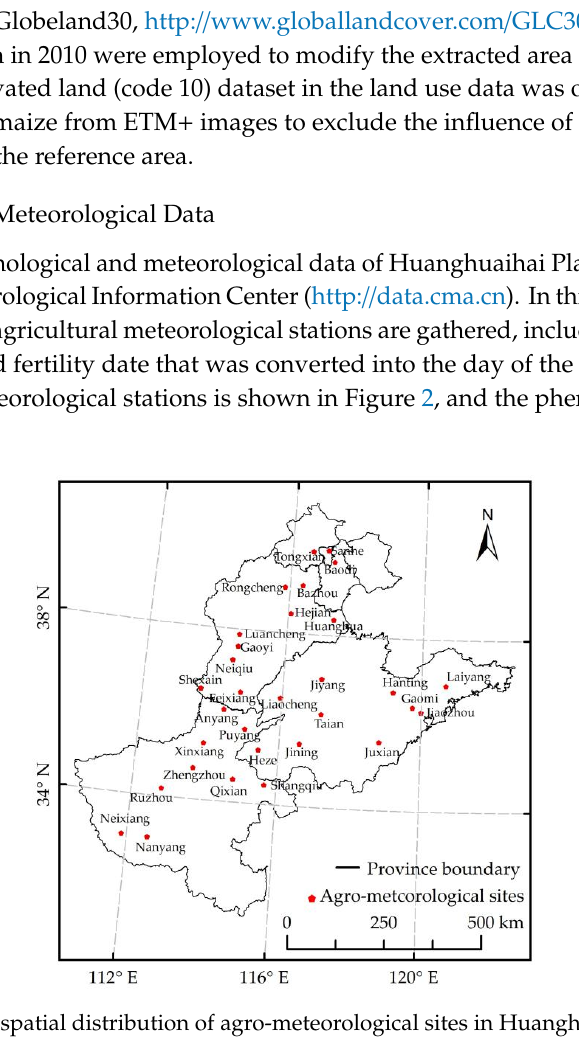
Figure 2. The spatial distribution of agro ‐ meteorological sites in Huanghuaihai Plain.